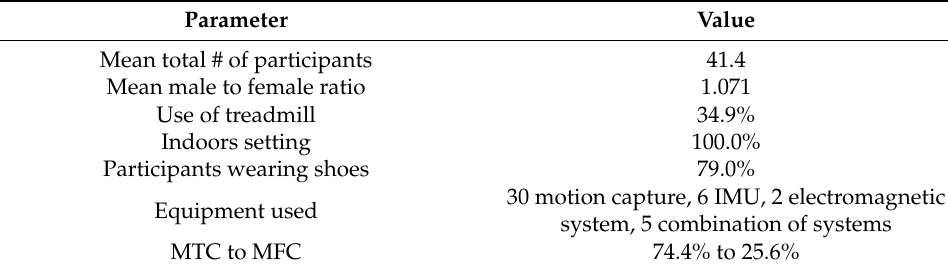
Table 1. Study design characteristics in included